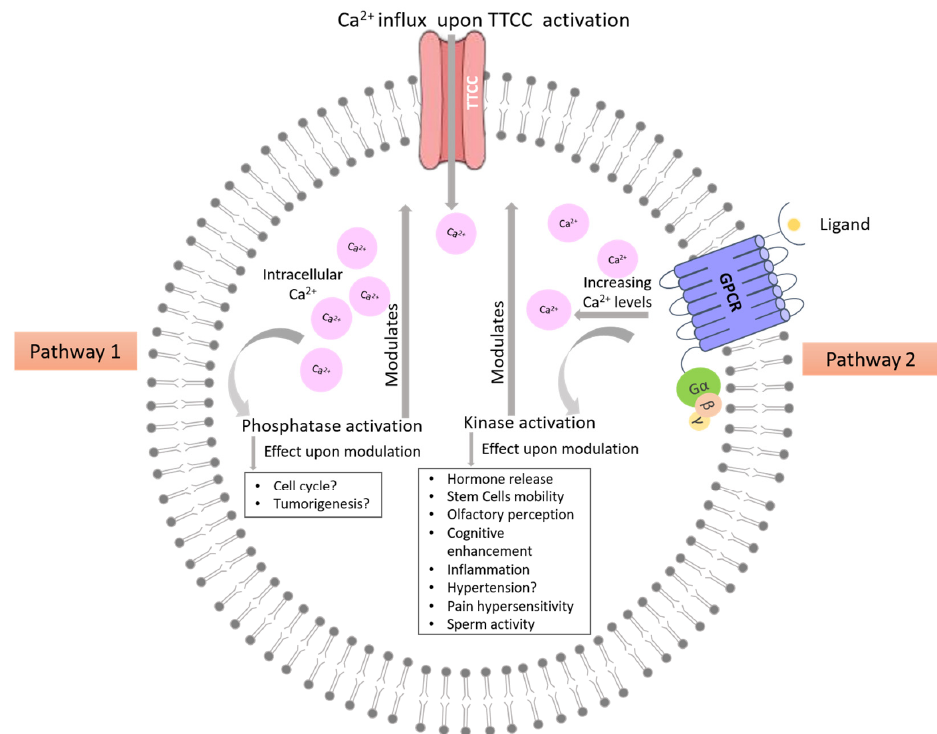
Figure 3. General scheme of TTCC modulation by Kinases and phosphatases. Pathway 1 shows the phosphatase activation via increase in intracellular Ca 2+ levels, which then modulates the TTCC activity. Pathway 2 shows the kinase activation via GPCR, which in turn modulates TTCC activity. Question mark indicates that direct experimental evidence is awaited.